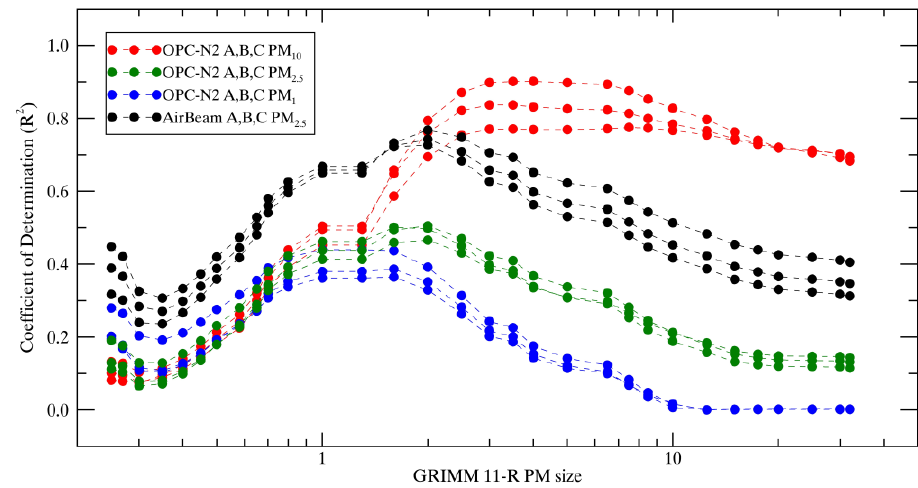
Figure 7. Coefficient of determination (R 2 ) of OPC-N2 PM 1 , PM 2.5 , PM 10 , AirBeam PM 2.5 and GRIMM 11-R-derived PM over a range of size ranges (PM from zero to size).